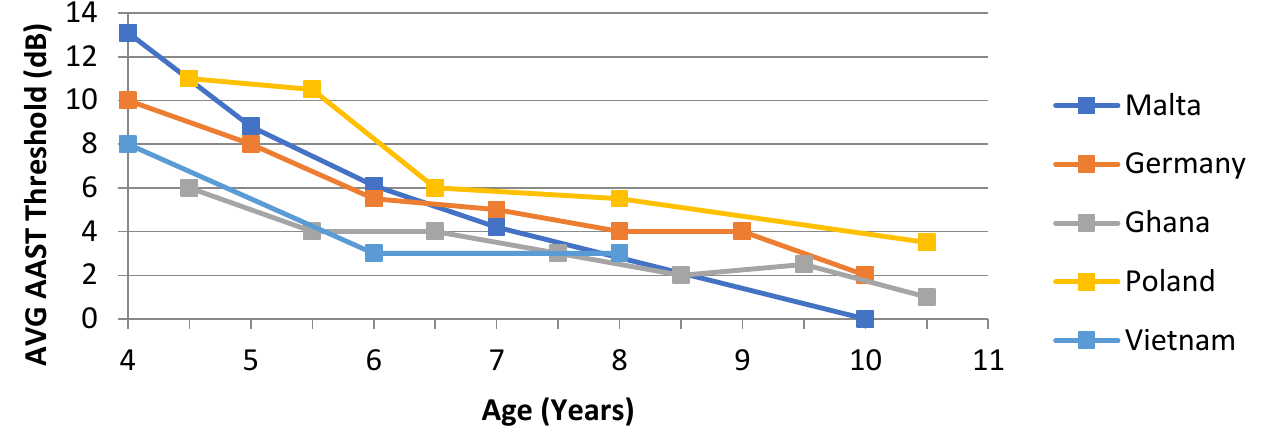
Figure 10. Age-related norm values in AAST in quiet across languages in comparison to the Maltese version. N.B. (Threshold plotted in y axis is the mean subtracted by 20dB; for example, in 6-year-old children, the average threshold is 25.3 dB SPL, and after correction with 20 dB, the THR is 5.3 dB HL).